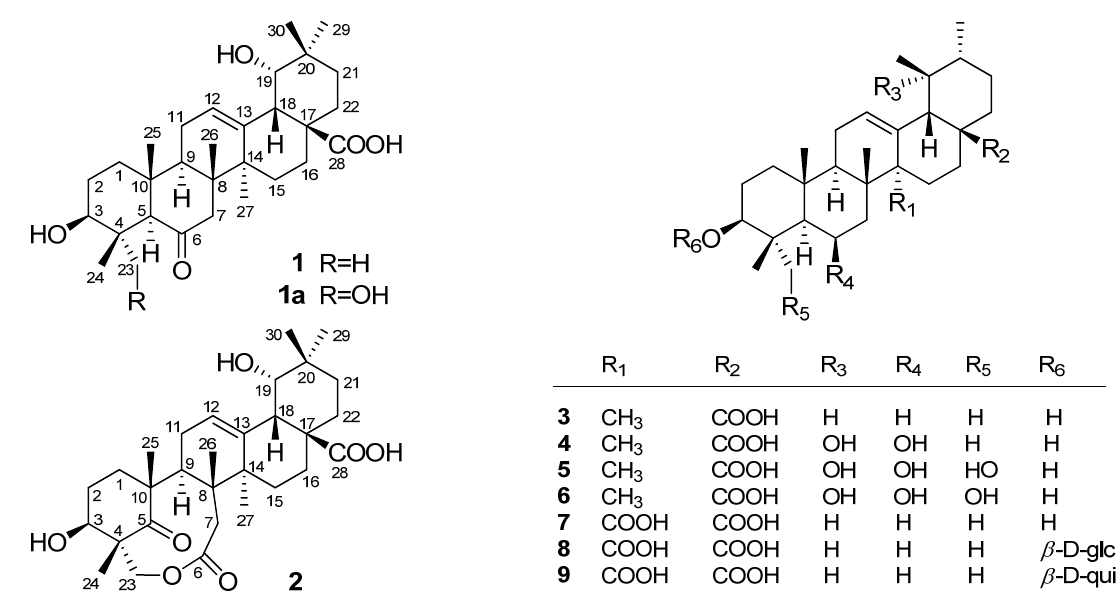
Figure 1. The chemical structures of compounds 1 − 9